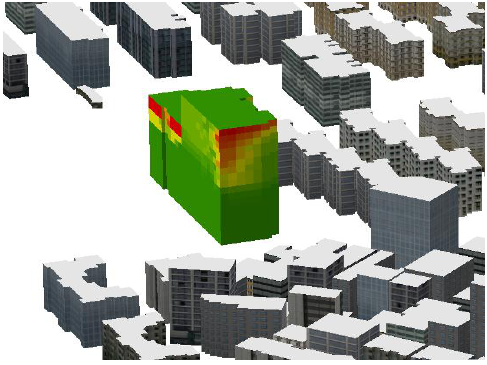
Figure 4. Schematic Diagram of Landscape Analysis